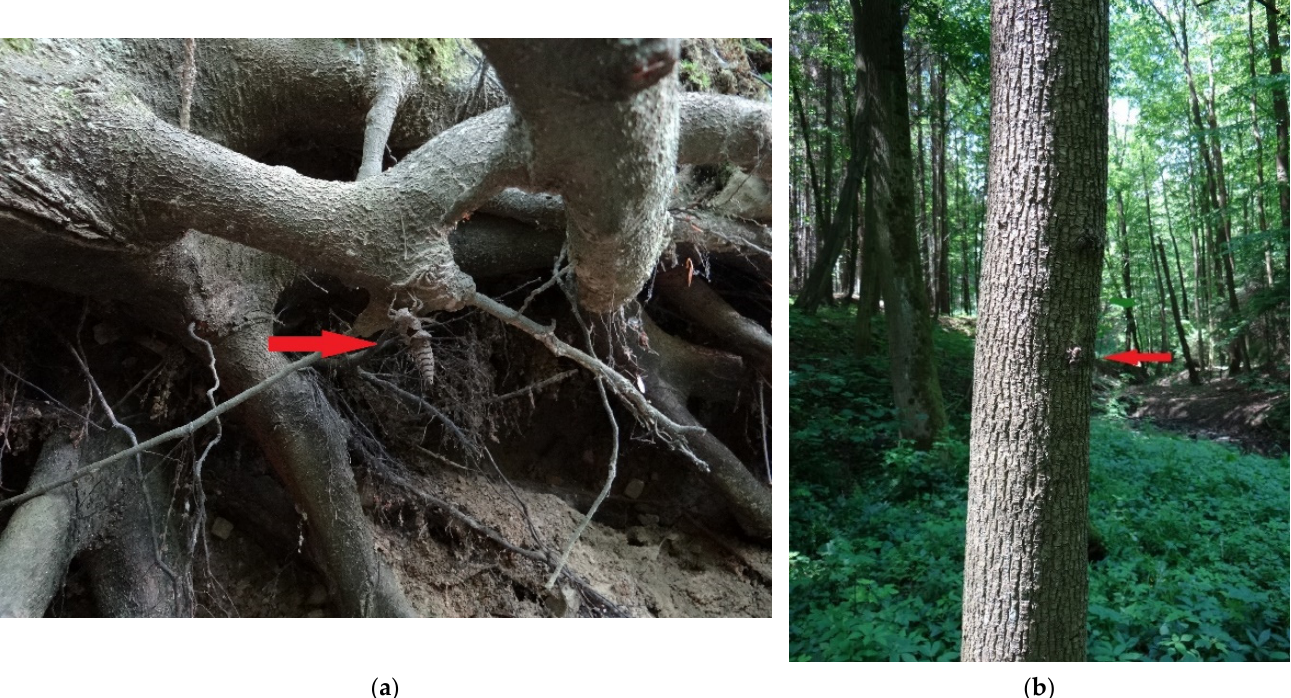
Figure 6. Position of exuviae of Cordulegaster heros : ( a ) on tree roots at steep bank, locality Cvr č ovický potok stream (Cvr č ovice cadastral territory, southern Czech Republic) (locality Ie), (4 June 2016, photo by Otakar Holuša); ( b ) on trunk of Alnus glutinosa , locality Cvr č ovický potok stream (Cvr č ovice cadastral territory, southern Czech Republic) (locality Ie), (8 July 2016, photo by Otakar Holuša).